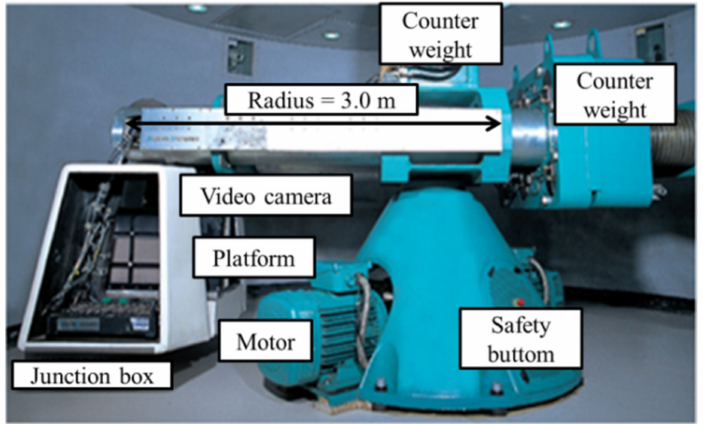
Figure 2. Geotechnical centrifuge (modified version of the machine in Daewoo Institute of Construc- tion Technology in Seoul, Korea).